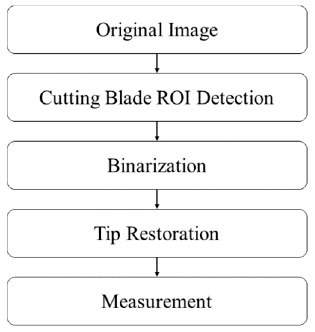
Figure 2. Flowchart for the cutting blade detection algorithm. ROI: region of interest.